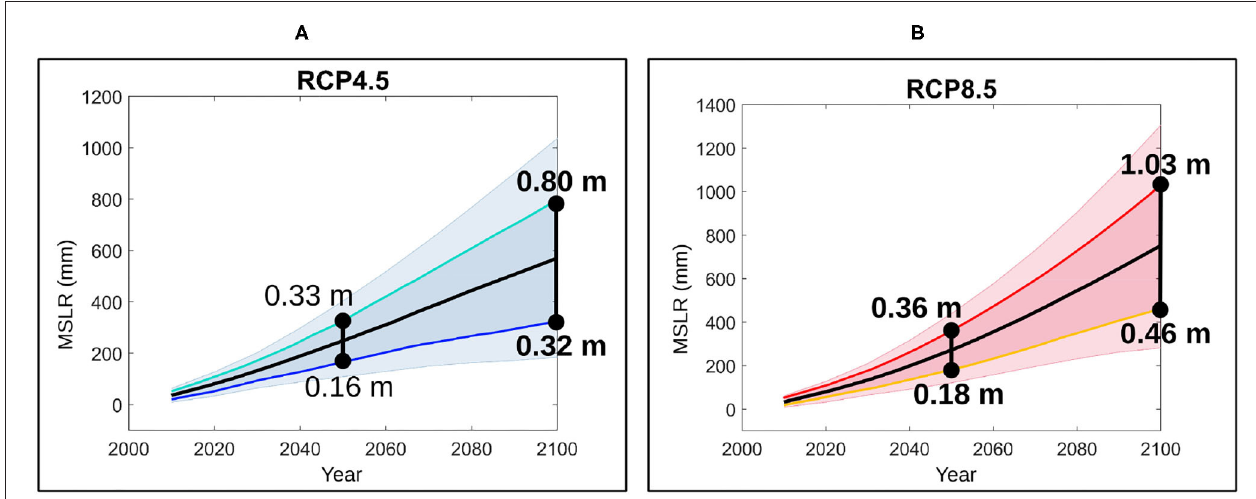
FIGURE 2 | MSLR projections under RCP4.5 (A) and RCP8.5 (B) climate scenarios, calculated according to Kopp et al. (2014). Black lines indicate the multi-model ensemble median and shadowed regions indicate the 17–83% and the 5–95% probability intervals. The four colored lines indicate the MSLR evolutions considered for the analysis of beach erosion, while the six values labeled in bold indicate the MSLR cases considered for the analysis of coastal flooding.